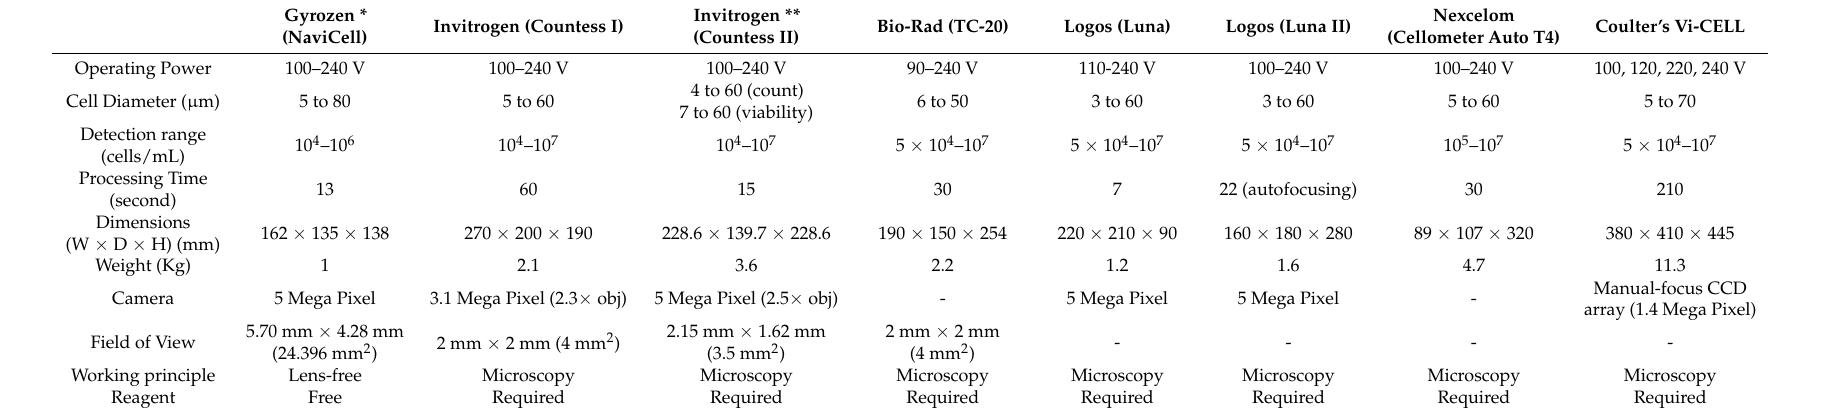
Table 1. Overview of the NaviCell and commercial cell